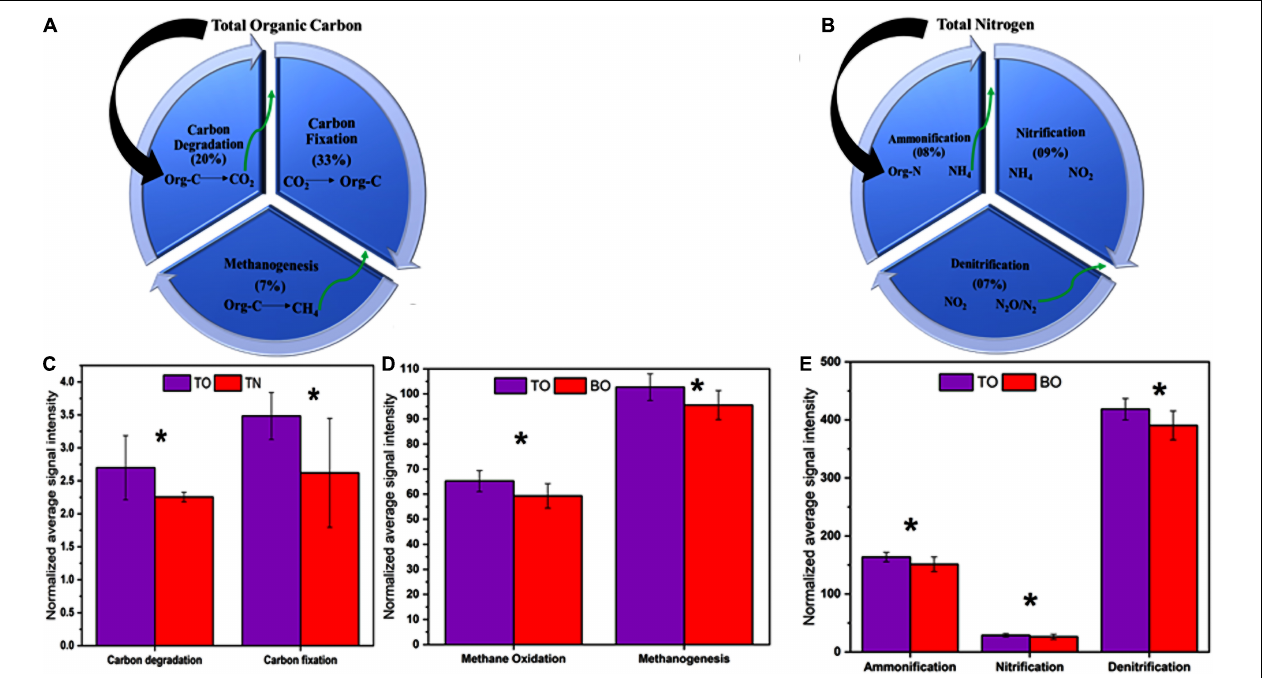
FIGURE 7 | Effect on major biological processes related to carbon and nitrogen. (A) Percent of total organic carbon converted to CO 2 via carbon degradation, reconversion of organic carbon from CO 2 , and final degradation to methane. (B) Percent of total nitrogen converted to NH 4 via ammonification, conversion of NH 4 to nitrite, and final conversion of nitrite to N 2 /N 2 O gases. (C) Key genes involved in carbon degradation and fixation processes. (D) Key genes involved in methane oxidation and methanogenesis. (E) Key genes involved in ammonification, denitrification, and nitrification. Error bars denote the standard deviation (SD) of the mean ( n = 16). An asterisk indicates significant differences between groups at p <